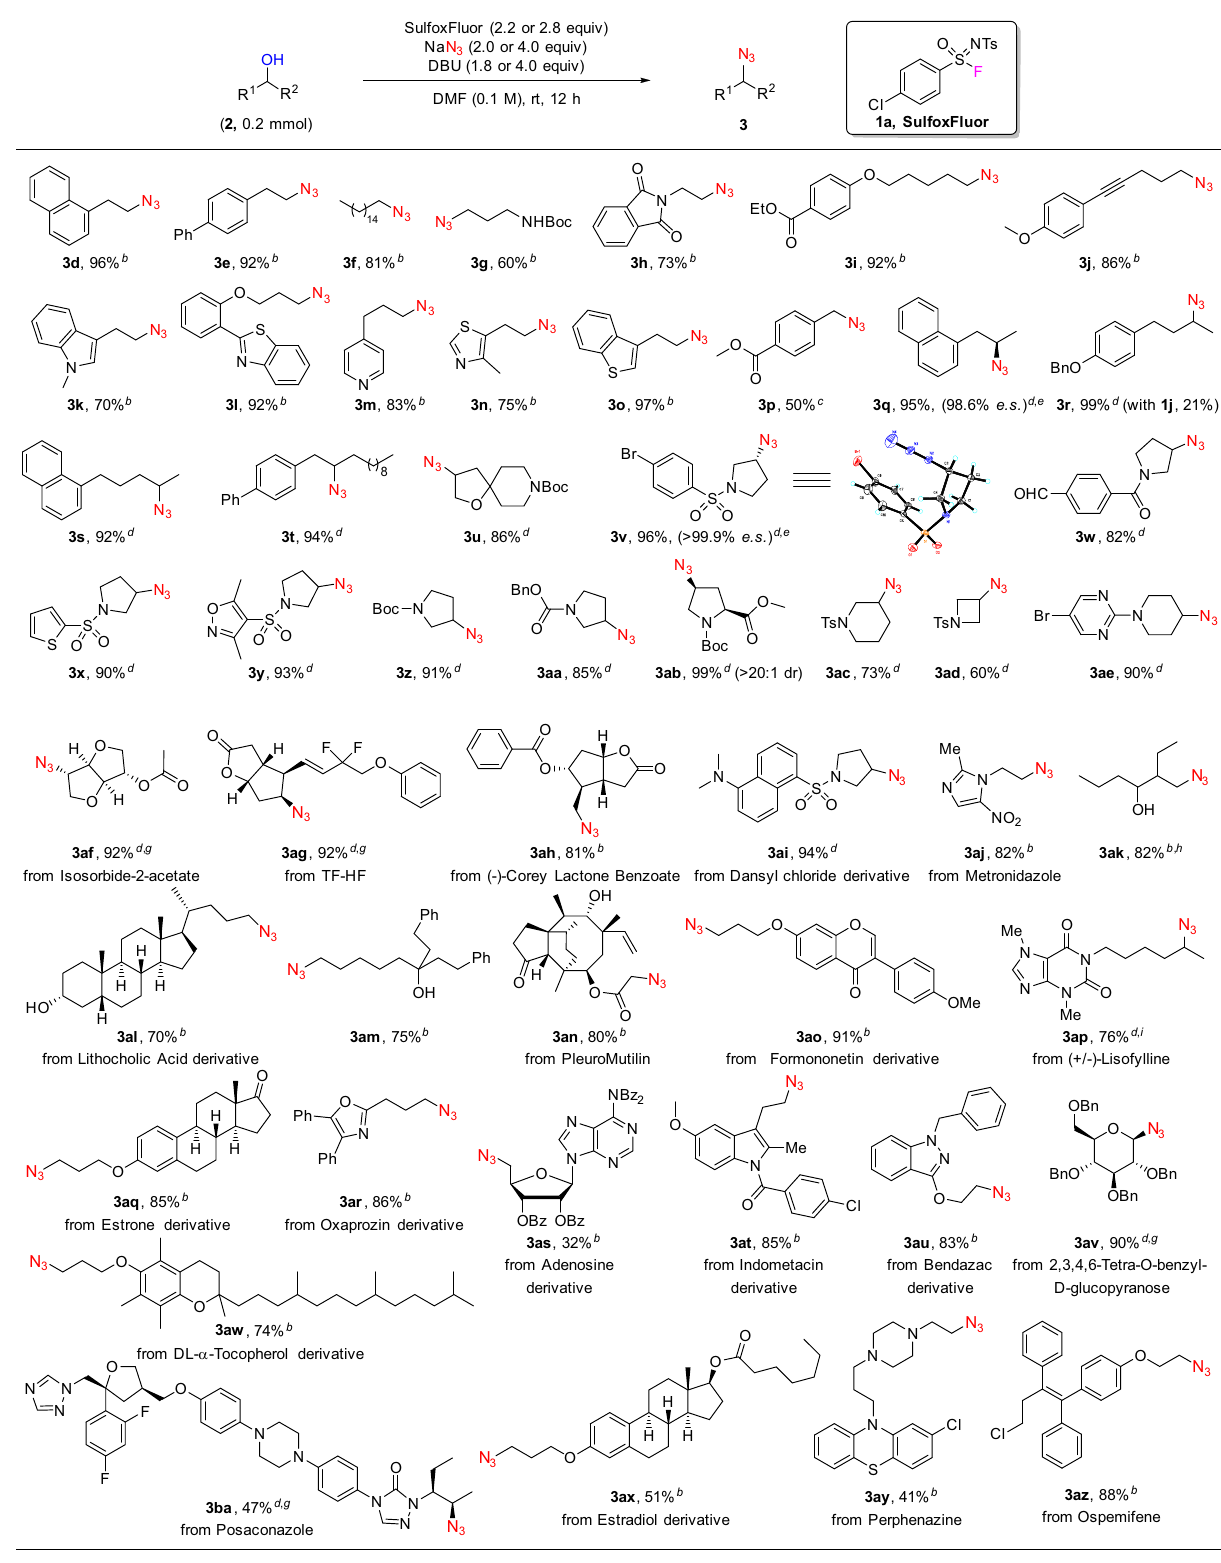
Fig. 2 Azidation of alcohols using SulfoxFluor a . a Isolated yields. b For primary alcohols: reactions were conducted on 0.2 mmol scale using 2.2 equiv of SulfoxFluor, 4.0 equiv of NaN 3 and 1.8 equiv of DBU. c Reaction was conducted on 0.2 mmol scale using 2.5 equiv of SulfoxFluor, 5.0 equiv of NaN 3 , and 1.8 equiv of DBU. d For secondary alcohols: reactions were conducted on 0.2 mmol scale using 2.8 equiv of SulfoxFluor, 2.0 equiv of NaN 3 , and 4.0 equiv of DBU. e The abbreviation e.s. refers to enantiospeci fi ty, e.s. = (e.e. of 3 )/(e.e. of 2 ) × 100%. f Reaction was conducted on a 0.2 mmol scale using 1.05 equiv of 1j , 4.0 equiv of NaN 3 , and 1.2 equiv of DMAP in DMF (0.2 M) at rt for 12 h. g Epimer ratio >20:1. h Reaction was conducted on a 0.4 mmol scale. i Reaction was conducted on a 0.16 mmol